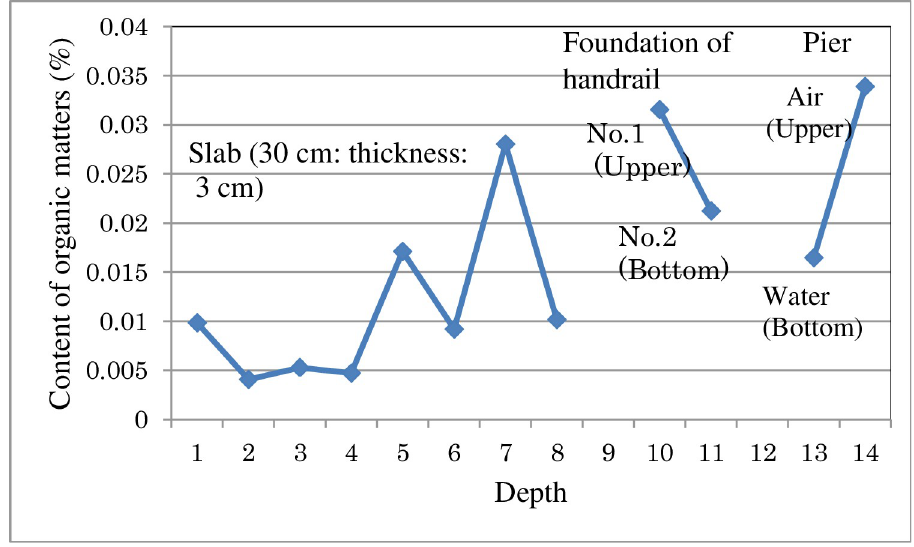
Fig 5. Distribution of organic matter contents of concrete slab, foundations of handrail, and bridge supporting pier.